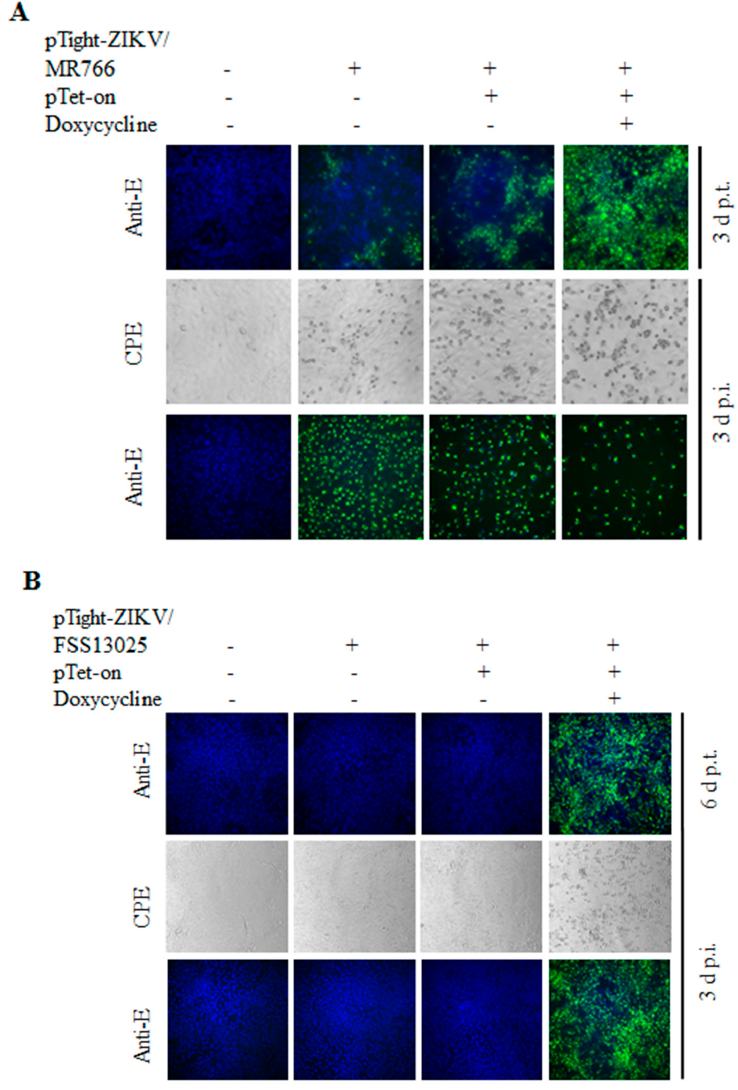
Figure 2. Production of cDNA-derived infectious ZIKV. ( A ) Production of infectious ZIKV/MR766 virus upon DNA transfection with or without Tet-induction. Vero cells (2.5 × 10 5 /well) in 12-well cell culture plates were transfected with 1 µ g of pTight-ZIKV/MR766 DNA and 1 µ g of empty vector or pTet-On vector using lipofectamine 2000. At 3 days p.t., the viral E protein in the DNA-transfected cells was detected by immunofluorescence assay (IFA) using an E-specific monoclonal antibody (D1-4G2-4-15). At the same time, the supernatants were used to infect fresh Vero cells. At 3 days p.i., the cytopathic effect (CPE) was recorded and the E protein in the ZIKV/MR766-infected cells was determined by IFA. ( B ) Determination of cDNA-derived ZIKV/FSS13025 replication and production by CPE and IFA. Experiments were carried out in the same way as in ( A ) except that the pTight-ZIKV/FSS13025 DNA was used. At 6 days p.t., the E protein was detected by IFA in the pTight-ZIKV/FSS13025 DNA-transfected Vero cells. The ZIKV/FSS13025 in the supernatant was used to infect Vero cells. At 3 days p.i., CPE was photographed and the E protein was measured by IFA as described in ( A ). Images in (A) and (B) were 200× magnification.